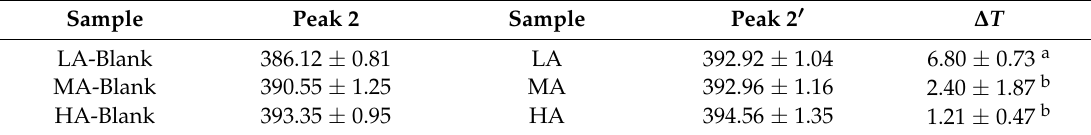
Table 1. Peak temperature values ( ◦ C) of starch-based composites with and without